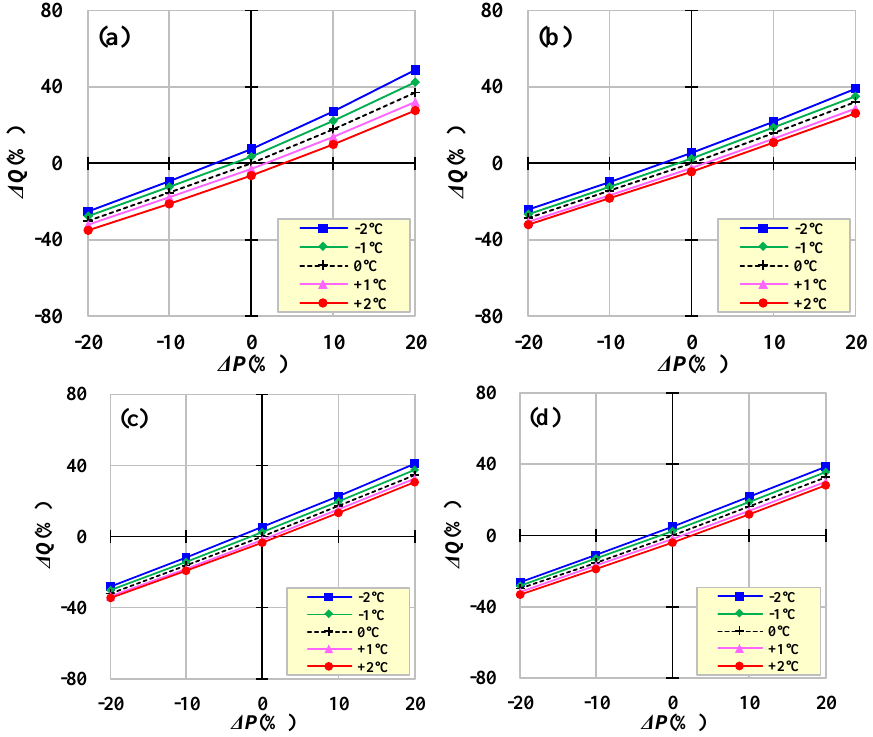
Figure 8. Sensitivity on mean streamflow due to mean precipitation change in JRB: Zhimenda ( a ); Shigu ( b ); Panzhihua ( c ); and Huatan ( d ).